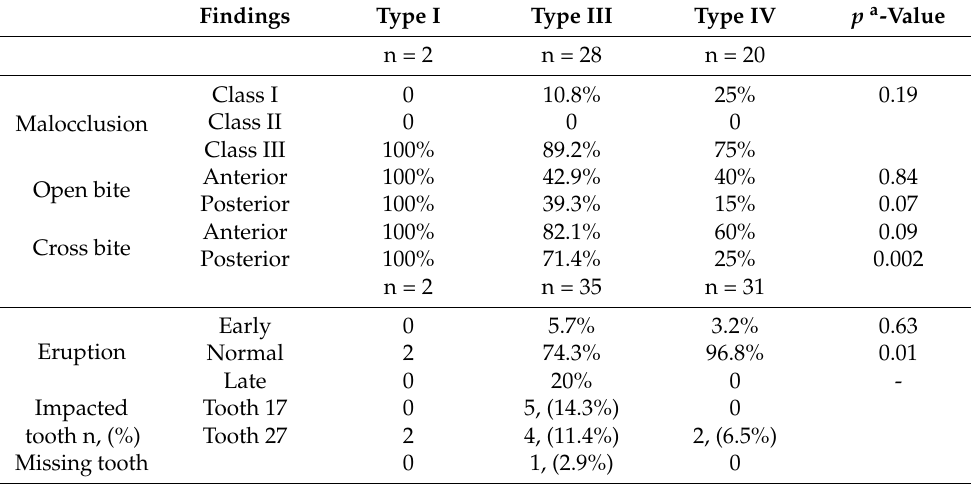
Table 4. Occlusion problems, impacted and missing teeth in OI